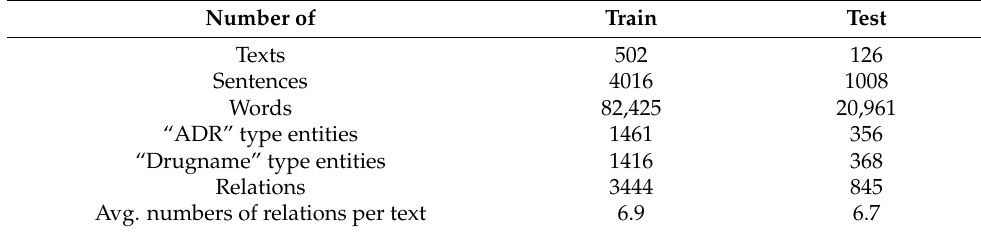
Table 3. Statistics on the part of RDRS dataset that is comprised of ADR–Drugname relations.